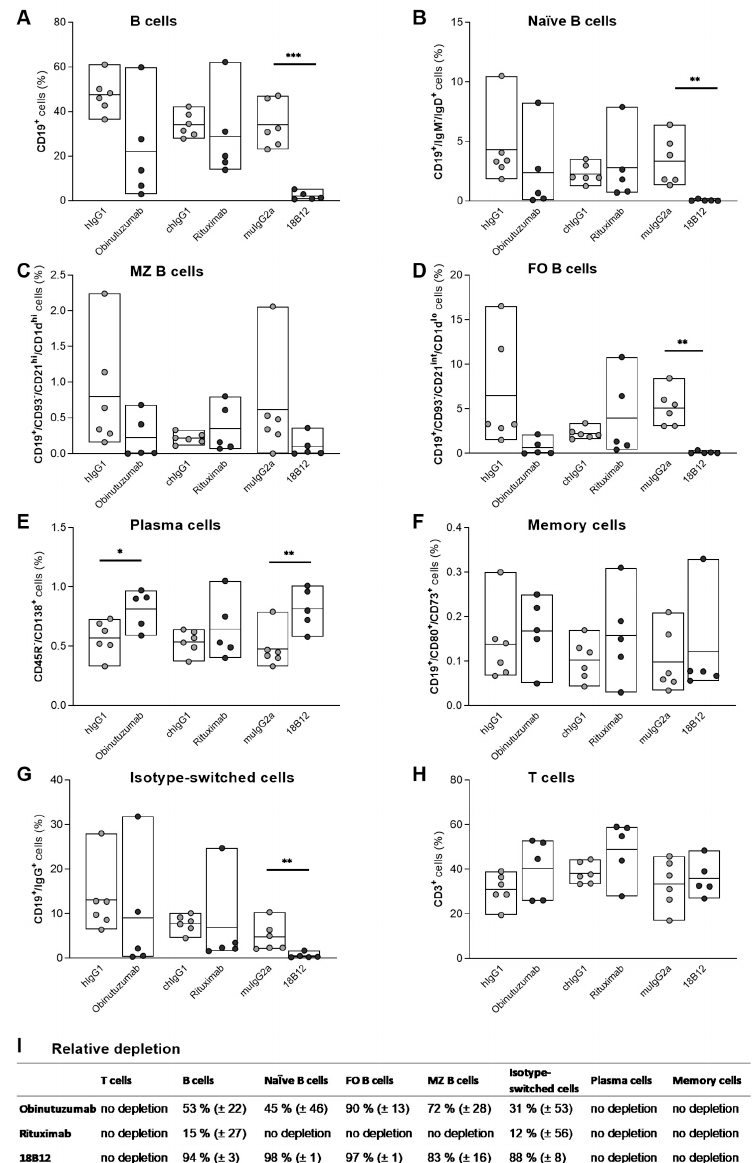
Figure 3. Depletion of splenic B cell subsets by anti-CD20 mAbs in hCD20xhIgR3 and WT B6 mice. Spleen cells were harvested from 5 to 6 animals per group, 7 days after injection with 5 mg/kg of obinutuzumab, rituximab, 18B12, or the corresponding isotype controls. Using flow cytometry, cells were gated on single live lymphocytes followed by the identification of different B cell subsets using five separate antibody panels. Percentages were calculated in reference to the total lymphocyte population. ( A ) B cells were defined as CD19 + , ( B ) naïve B cells as CD19 + /IgM − /IgD + , ( C ) marginal zone B cells as CD19 + /CD93 − /CD21 hi /CD1d hi , ( D ) follicular B cells as CD19 + /CD93 − /CD21 int /CD1d lo , ( E ) plasma cells as CD45R − /CD138 + , ( F ) memory cells as CD19 + /CD80 + /CD73 + , and ( G ) isotype- switched cells as CD19 + /IgG + . ( H ) T cells were defined as CD3 + . Each circle represents the mean value of an individual mouse. The bars indicate the group mean value as well as minimum and maxi- mum values. The following statistical tests were used for group comparisons: panels ( A , D ), Welch’s t -test; panels ( B , G ), Mann–Whitney U test; panel ( C ), unpaired t -test (OBZ), Welch’s t -test (RTX) and Mann–Whitney U test (18B12); panels ( E , F ), unpaired t -test; panel ( H ), unpaired t -test (OBZ); Welch’s t -test (RTX) and unpaired t -test (18B12). * p ≤ 0.05, ** p ≤ 0.01, *** p ≤ 0.001. ( I ) Relative depletion (mean ± SEM) of the different B cell subsets in anti-CD20 mAb- compared to isotype control-treated groups. FO, follicular; MZ, marginal